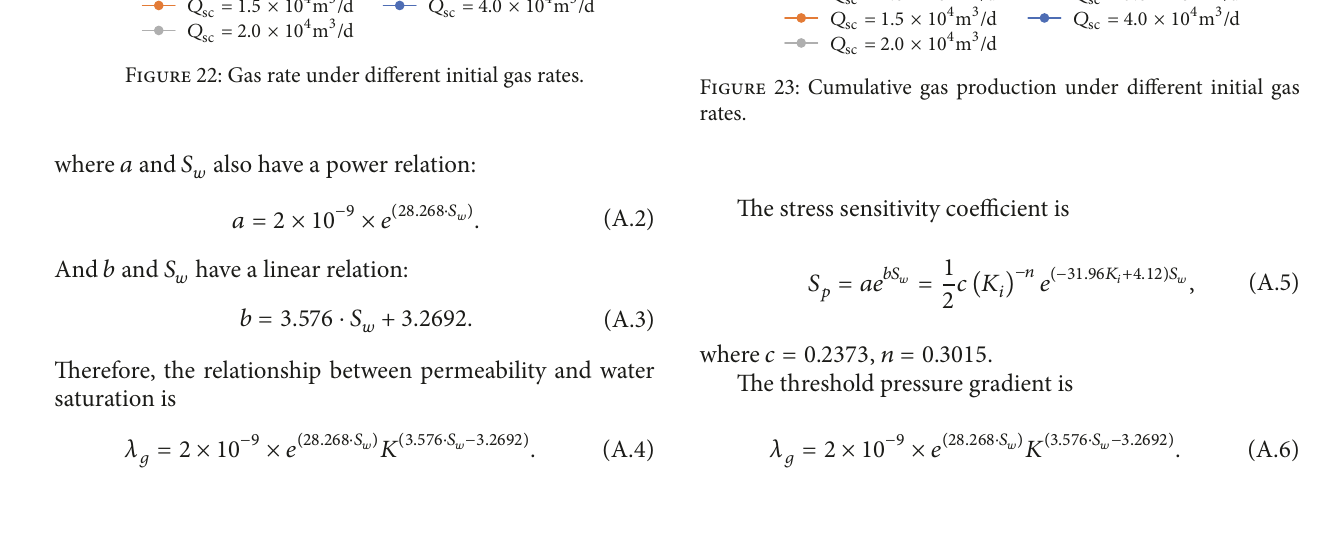
00.511.522.533.544.5